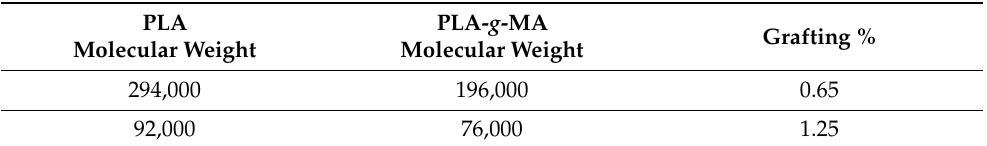
Table 1. Variations in molecular weight and grafting percentage during functionalization of PLA by MA (extract of data from Muenprasat et al. [23]).